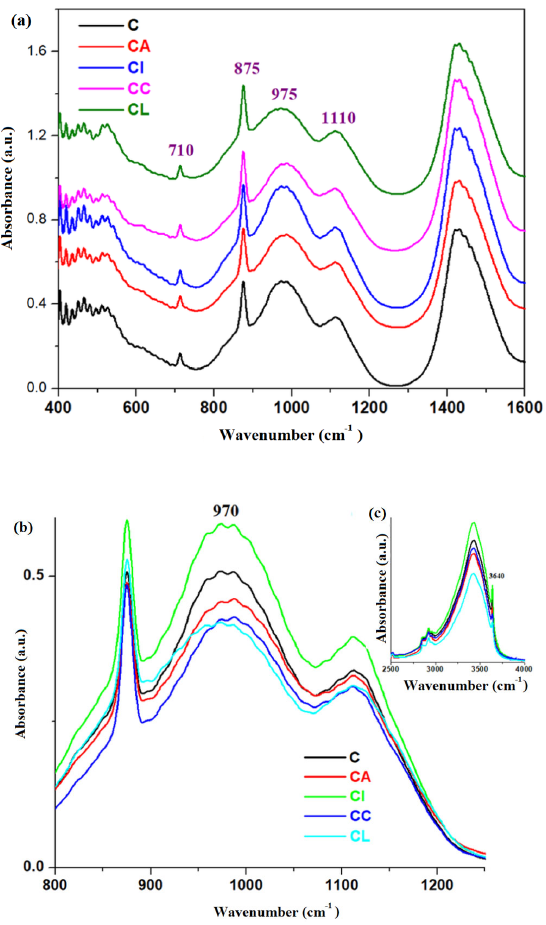
Figure 4. FTIR spectra of cement and composite-cement materials performed at 28 days after their preparation in the region between ( a ) 400 and 1600 cm − 1 , ( b ) 800 and 1250 cm − 1 , and ( c ) 2500 and 4000 cm − 1 .